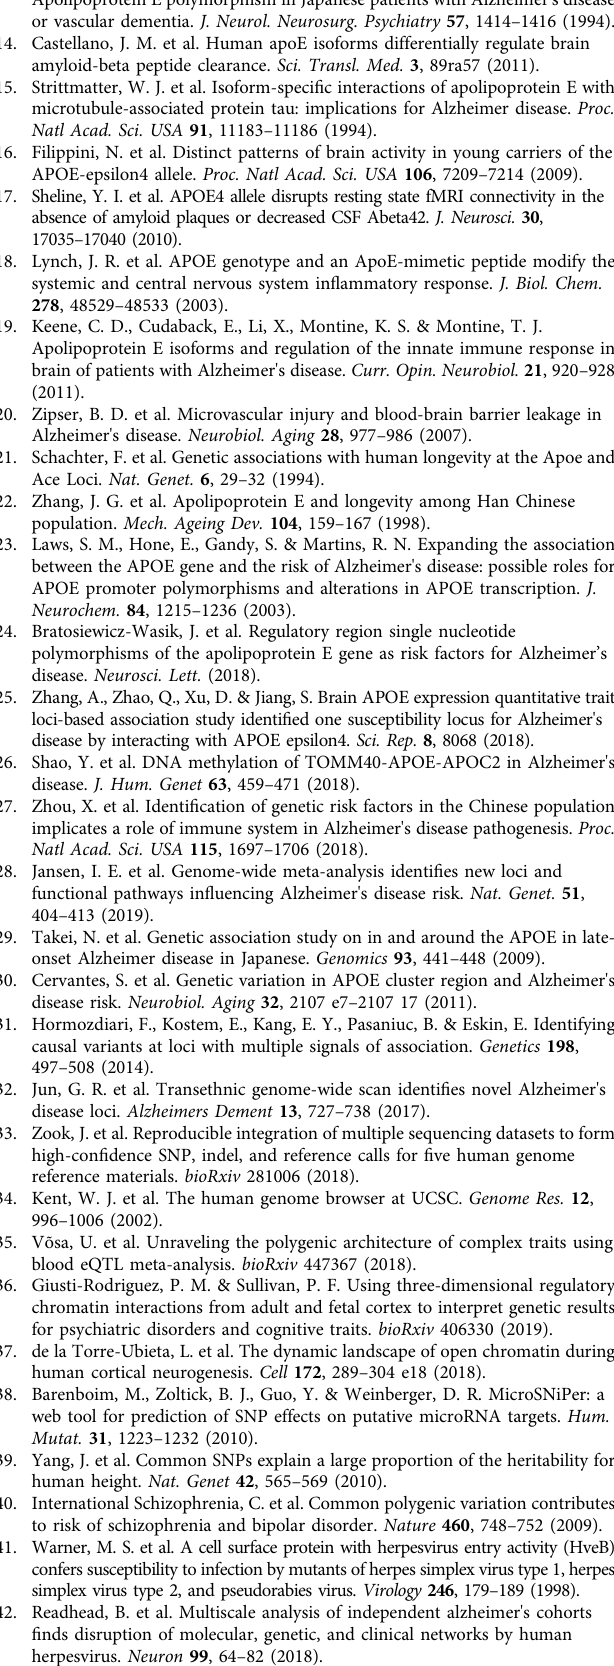
charts, dot plots, box plots, and line charts were generated using GraphPad Prism 6 (GraphPad Software Inc). Forest plots for meta-analysis were generated using ForestPMPlot 72 . Pie charts were generated using Excel 2017